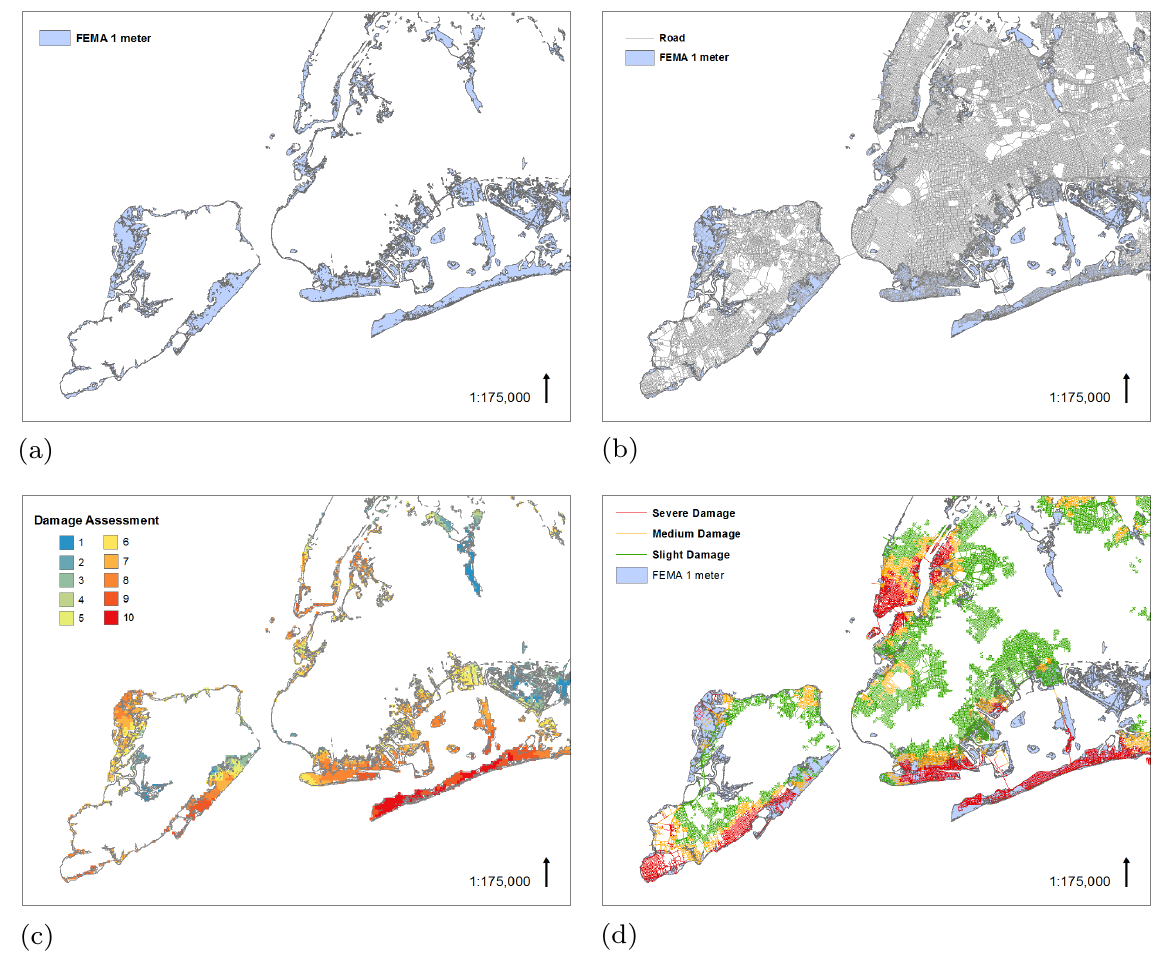
Fig. 3. (a) Storm surge created by FEMA MOTF for New York City. (b) Road network for NYC area and FEMA flood extent. (c) Damage assessment generated from non-authoritative data within FEMA surge boundary. (d) Road damage assessment based on analysis of non- authoritative data. Storm surge extent generated by FEMA and the road layer for New York City area (a and b). Flood damage assessment generated from non-authoritative data and the subsequent classification of potential road damage (c and d).